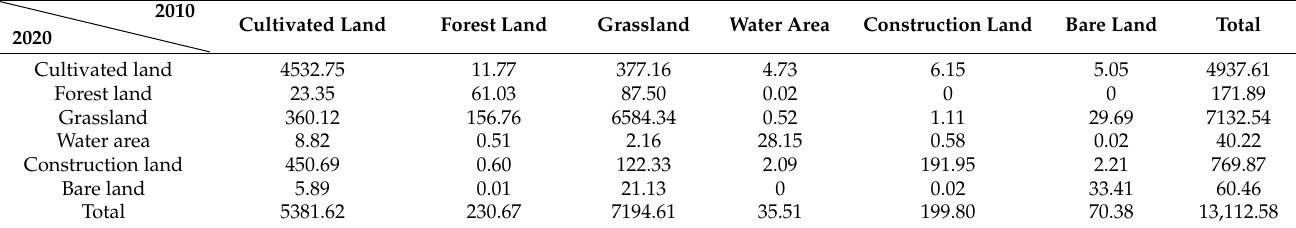
Table 8. The land use transfer matrix in Lanzhou from 2010 to 2020 (unit: km 2